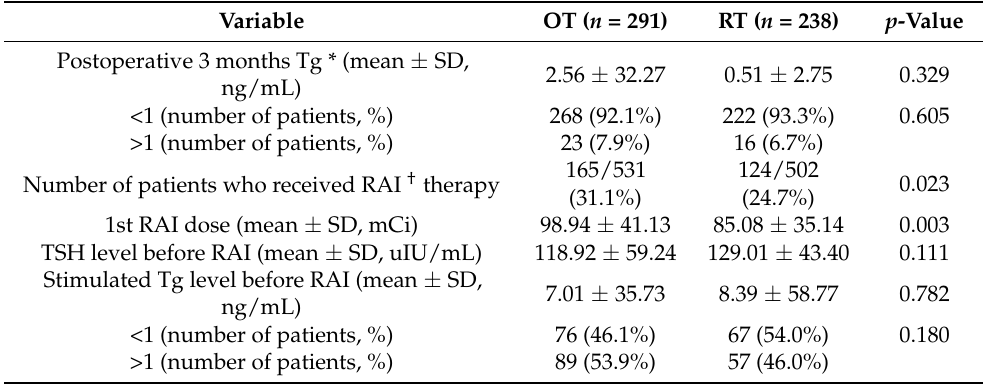
Table 3. Surgical completeness in total thyroidectomy patients.